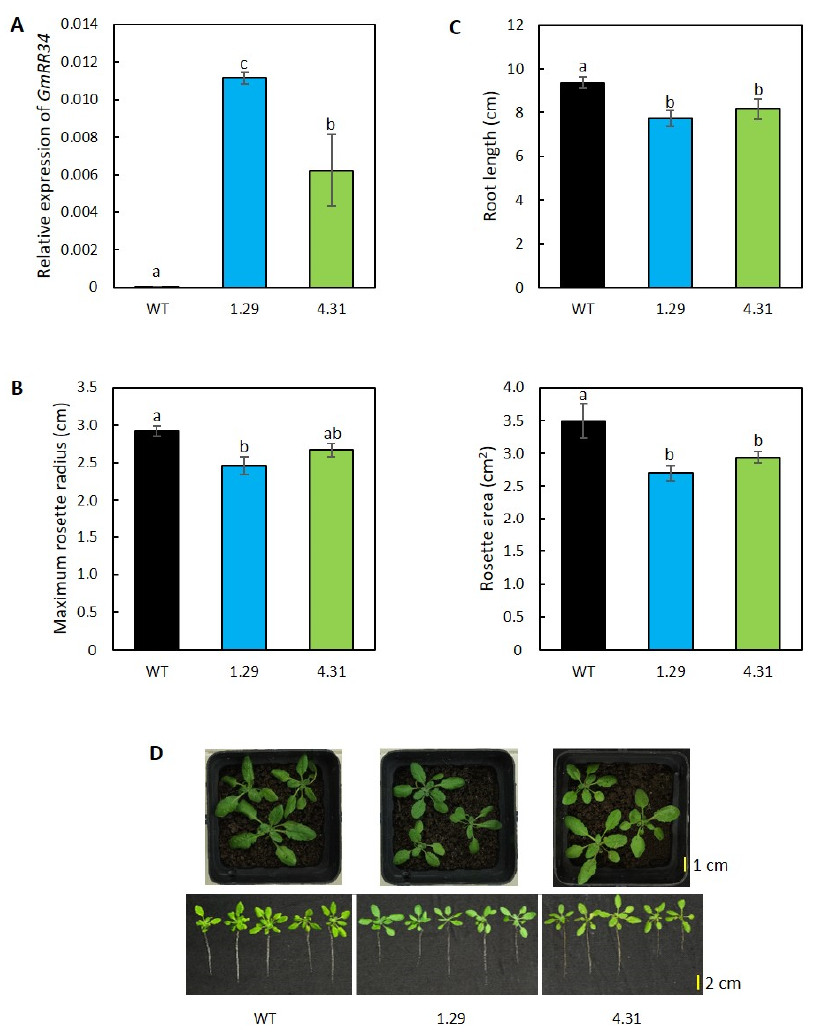
Figure 1. Transgene expression and phenotypic characteristics of Arabidopsis ectopically expressing GmRR34 (independent lines 1.29 and 4.31) under normal growth conditions. ( A ) Relative expression level of transgene in the ectopic expression lines using GmRR34 -specific primers. Wild-type plants were used as the control sample ( n = 3). ( B ) Maximum rosette radius and average rosette area ( n = 10). ( C ) Root length ( n = 10). ( D ) Overall rosette and primary root phenotypes. Error bars indicate standard errors. Statistically identified differences among three genotypes under the same treatment were indicated by different letters ( p -value < 0.05).